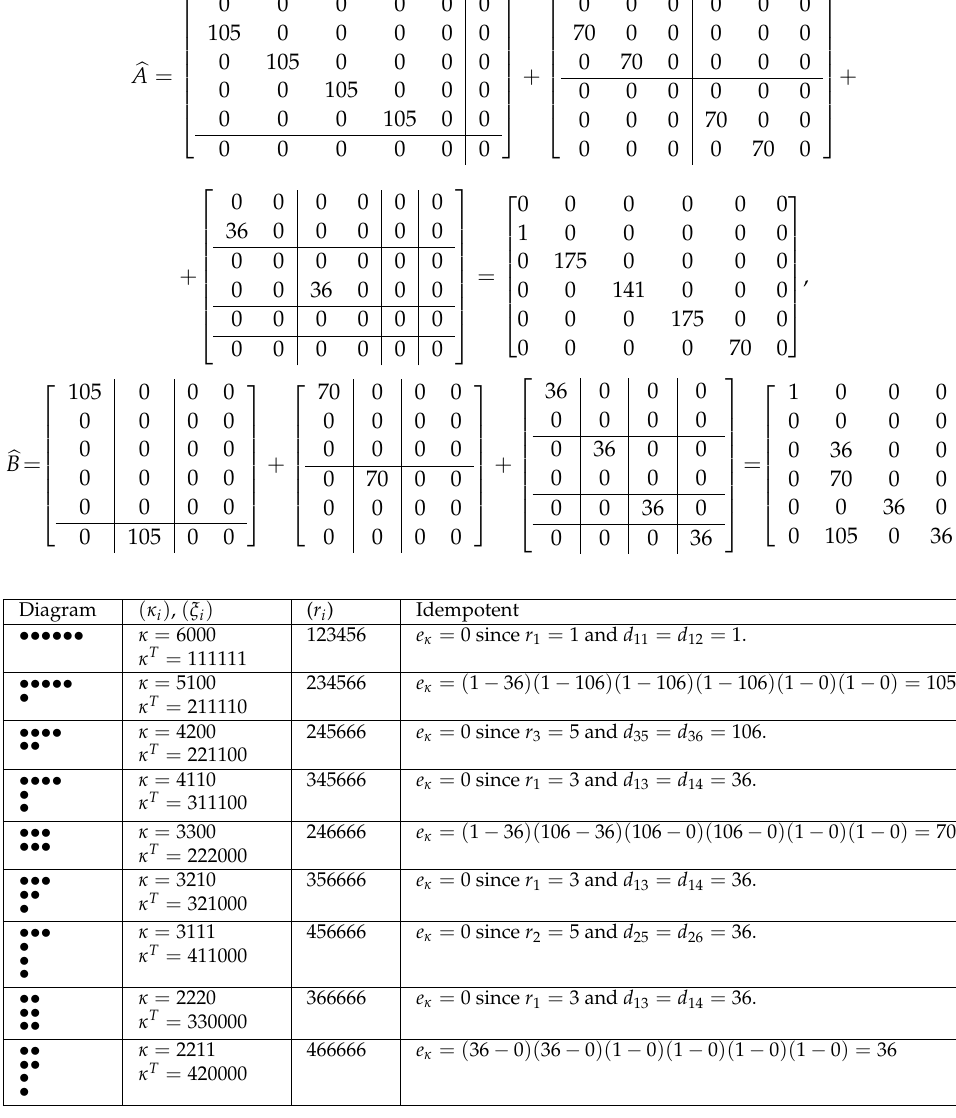
Figure 1. Calculation of the e κ in terms of the d ij in Example